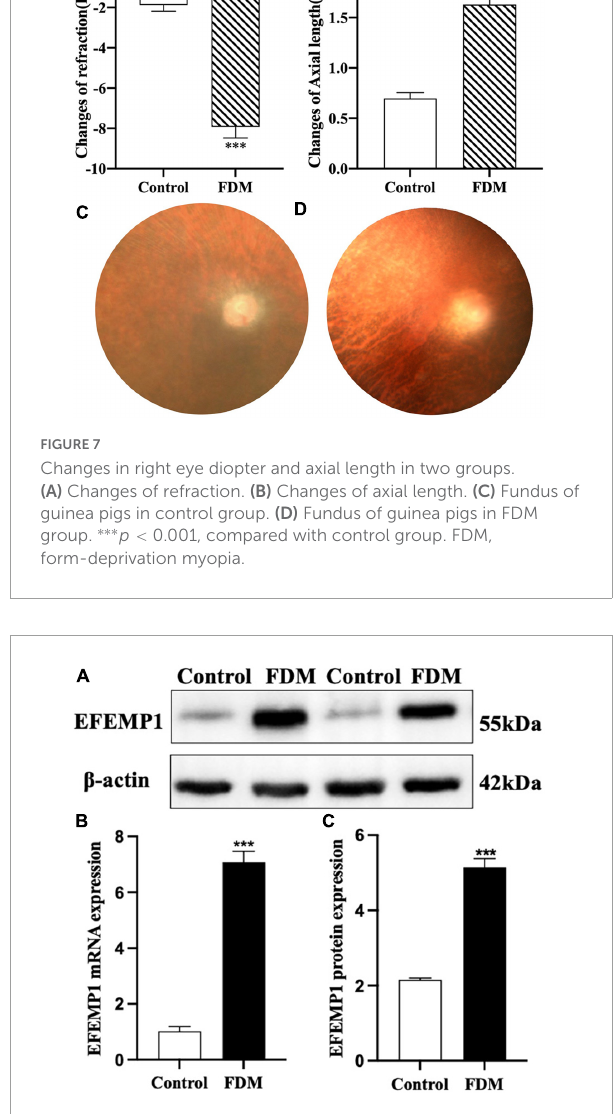
FIGURE8 Expression of EFEMP1 mRNA and protein. (A) Western blot image of the two groups. (B) mRNA expression of EFEMP1. (C) Protein expression of EFEMP1. *** p < 0.001, compared with control group, n =